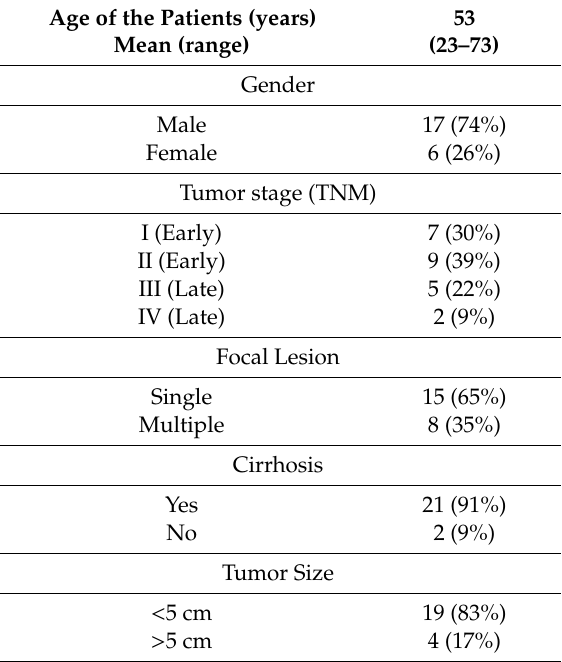
Table 2. Characteristics of hepatocellular carcinoma (HCC) patients and HCC